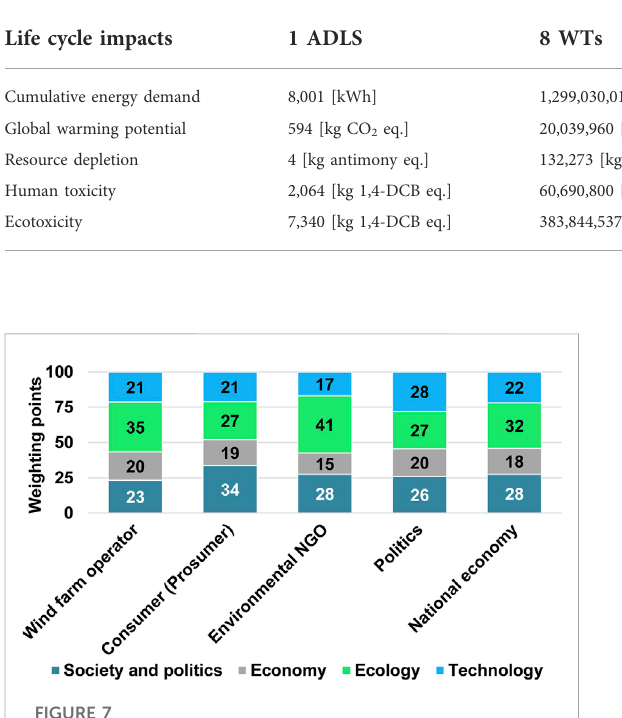
FIGURE 7 MCA weighting pro fi les.